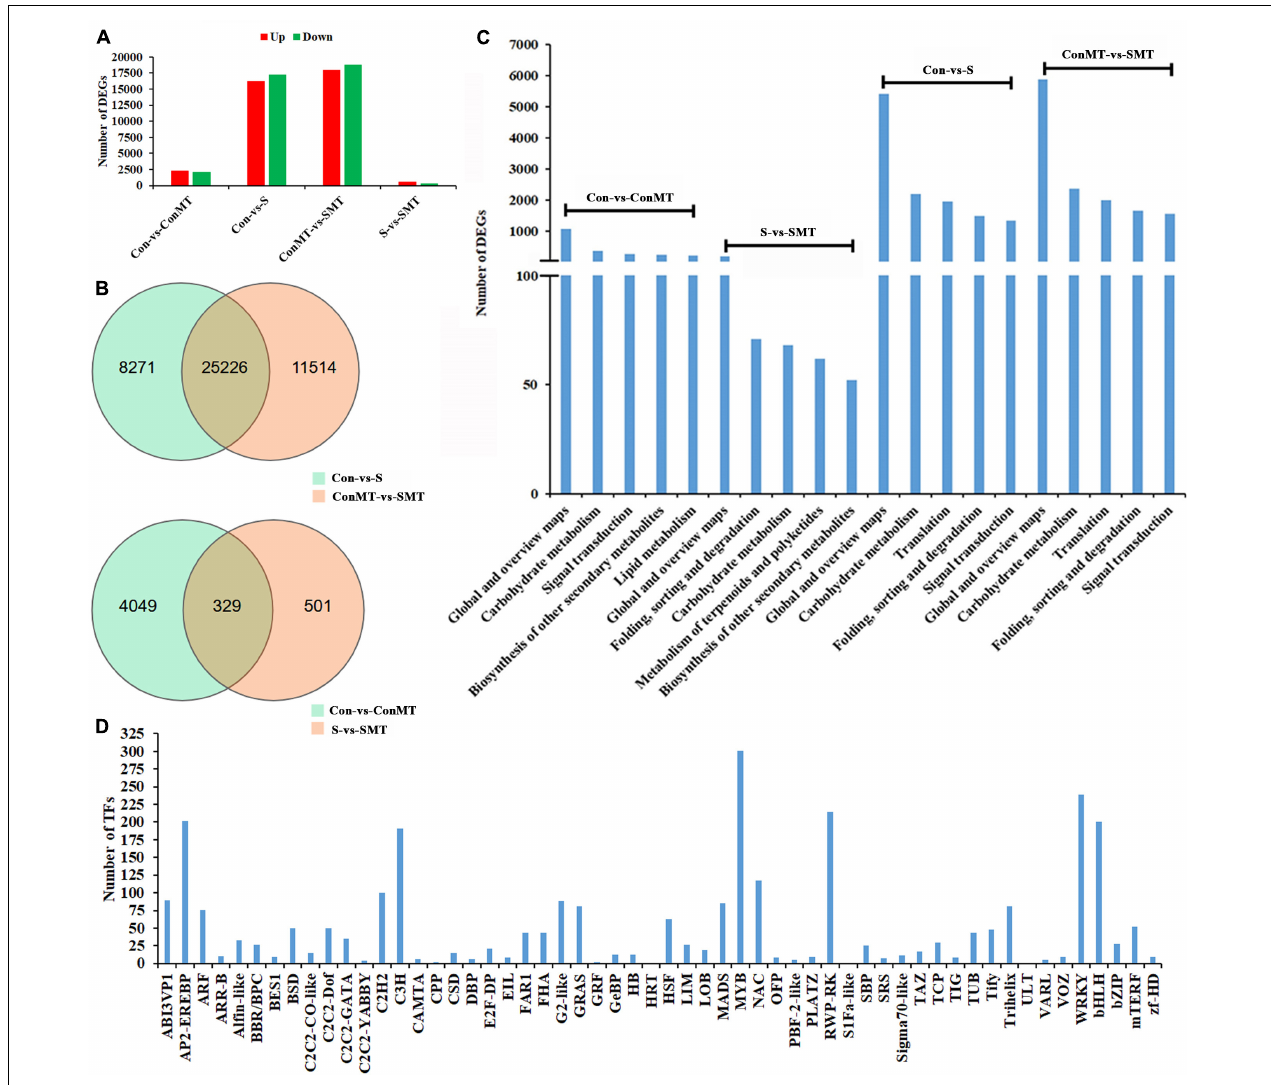
FIGURE 3 | Effects of exogenous melatonin and heat stress on gene expression. (A) Number of differentially expressed genes in different comparisons. (B) Overlapped differentially expressed genes in different comparisons. (C) KEGG analysis in different comparisons (top 5). (D) Number of TFs families. Con, control; S, heat stress; SMT, heat stress with exogenous melatonin treatment; ConMT, control with exogenous melatonin